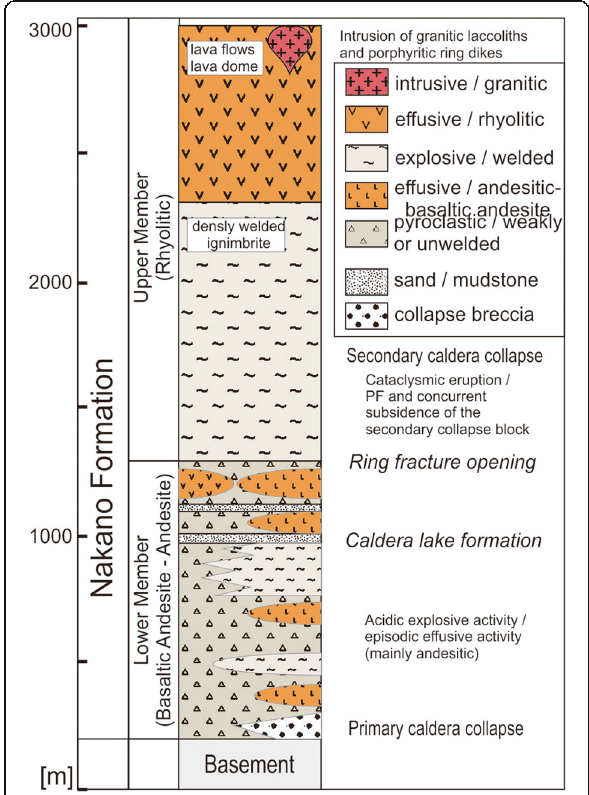
Fig. 6 Simplified stratigraphic section through the Sakurae Cauldron / Nakano Formation (Komuro et al. 2006). Notice the massive, approximately 1 km thick deposit of highly welded ignimbrites, erupted during the second major caldera